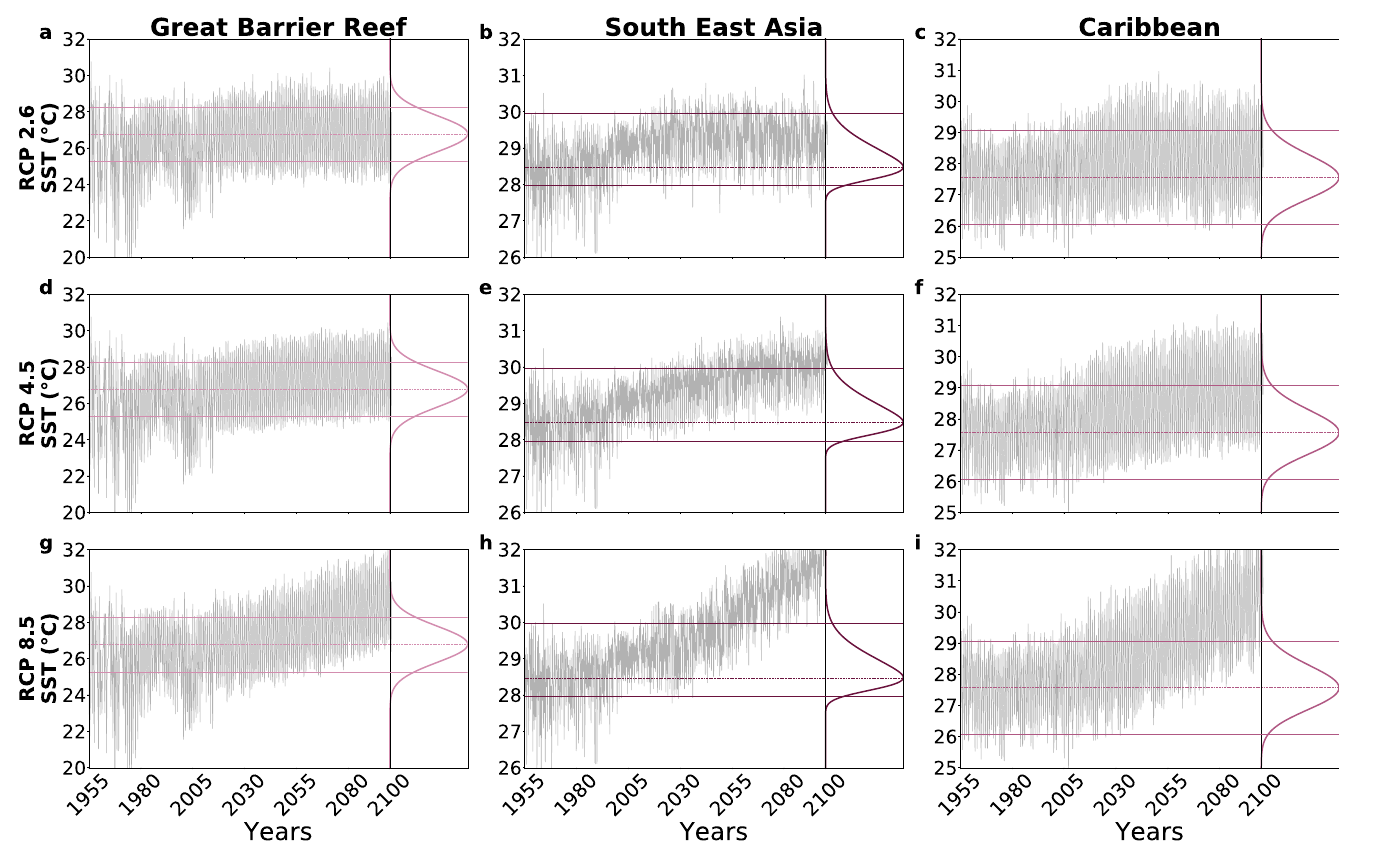
Fig 4. Monthly temperature forcing scenarios and thermal-limited coral growth curves. Low emissions (RCP 2.6) produce temperature trends (grey lines) that fall within the thermal-limited coral growth curves (coloured lines in the right side of each panel) in all regions (a - c) . As emissions increase (RCP 4.5), the trends in environmental temperatures move away from the temperature optima T opt (marked by dashed lines), especially in the South East Asia and in the Caribbean (d - f) and even fall outside the thermal tolerance curves under RCP 8.5 (g - i) . The dotted lines mark the limits of the coral thermal tolerances.